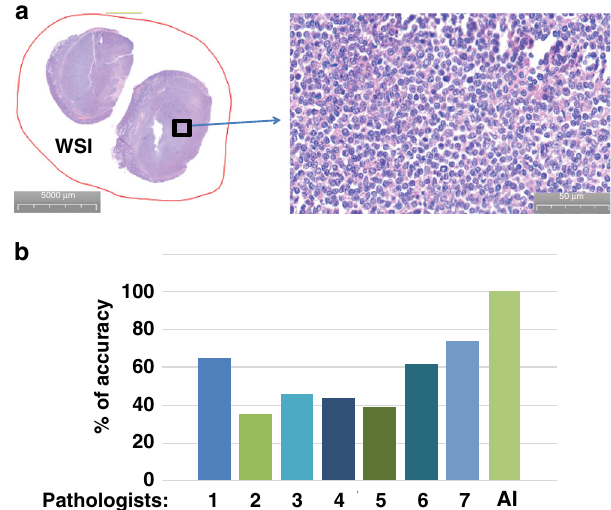
Fig. 4 Sensitivity of AI models. a Pathologic images of the sole case that was diagnosed as DLBCL by pathologists but was not recognized as DLBCL by our AI model. b Comparison of diagnostic accuracy of DLBCL between pathologists and our AI model by reading additional DLBCL and non-DLBCL lymph node samples (in total 531 400× images) from hospital B. Seven experienced pathologists were invited to read the images. The pathologists used about 60 min on average to read all 531 images with the highest diagnostic accuracy of 74.39%. In contrast, the diagnostic accuracy of our AI model was